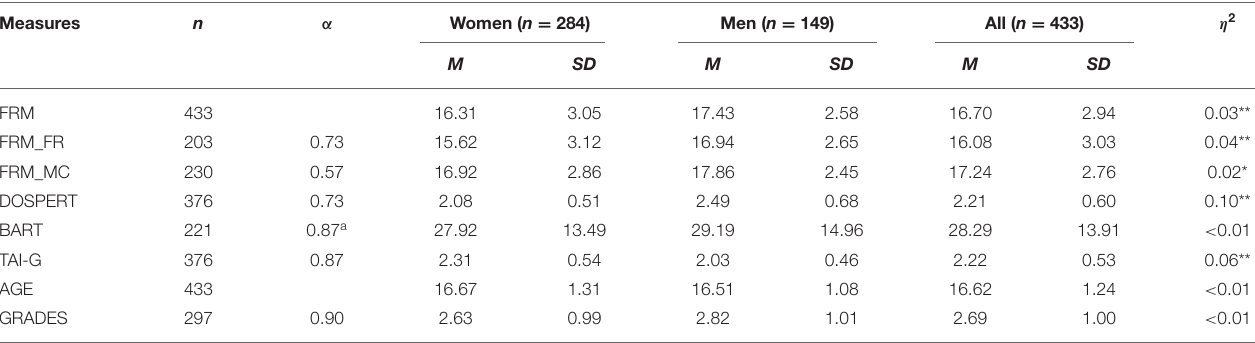
TABLE 1 | Descriptive statistics, reliability and mean differences between women and men.